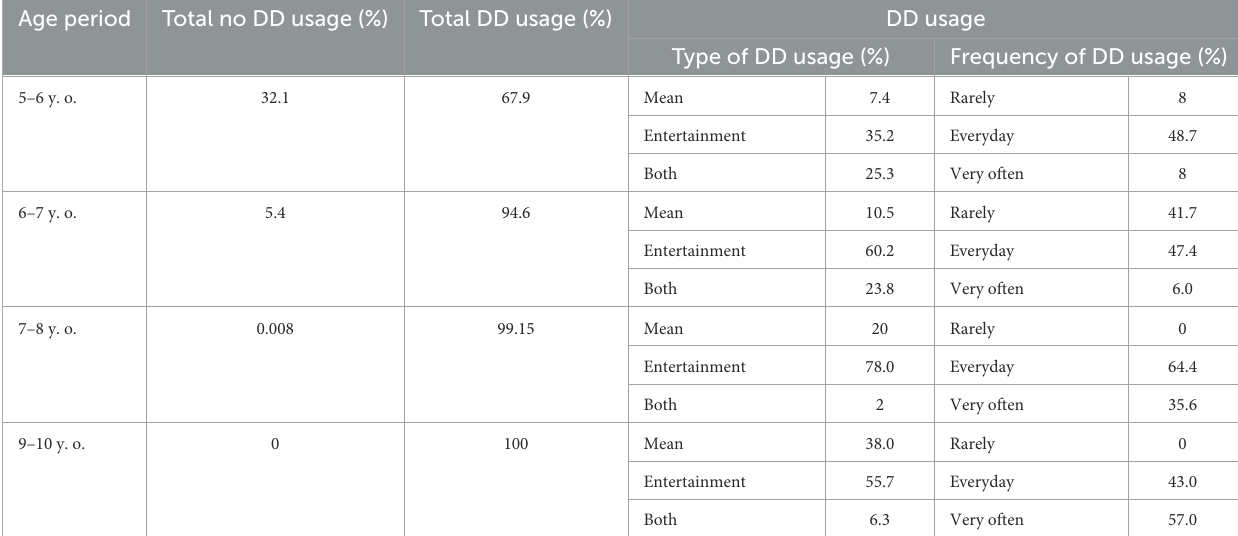
TABLE 1 Characteristics of child digital device usage at different